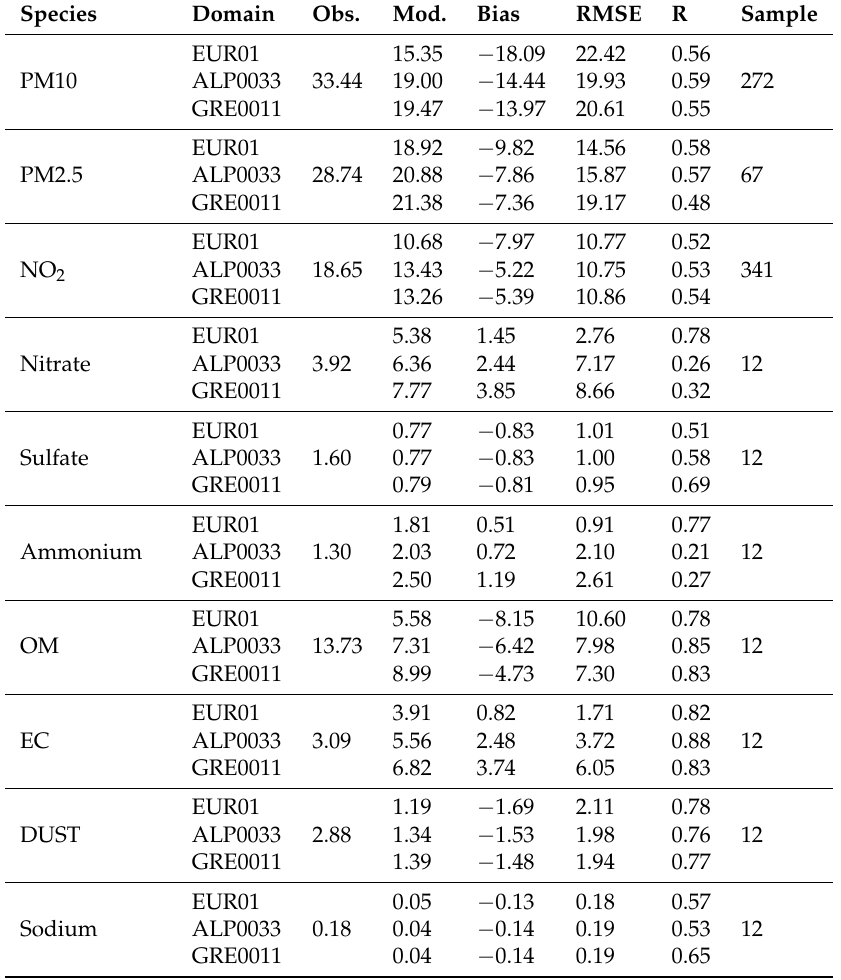
Table 6. Error statistics for the main pollutants. Mod., Obs., Bias and RMSE are respectively the mean model data, mean observations, mean bias and the root mean quare error in µ g m − 3 for the 15 Novermber to 20 December period. R is the Pearson product-moment spatio-temporal correlation coefficient (unit less). Calculations are done for the stations in the GRE0011 domain